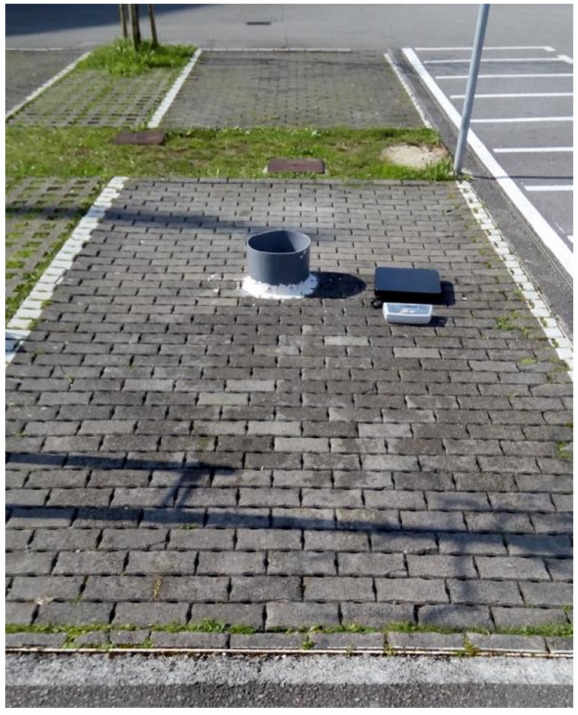
Figure 5. Setup of the infiltration ring for the ASTM C1781/C1781M-15 test on the ICBP